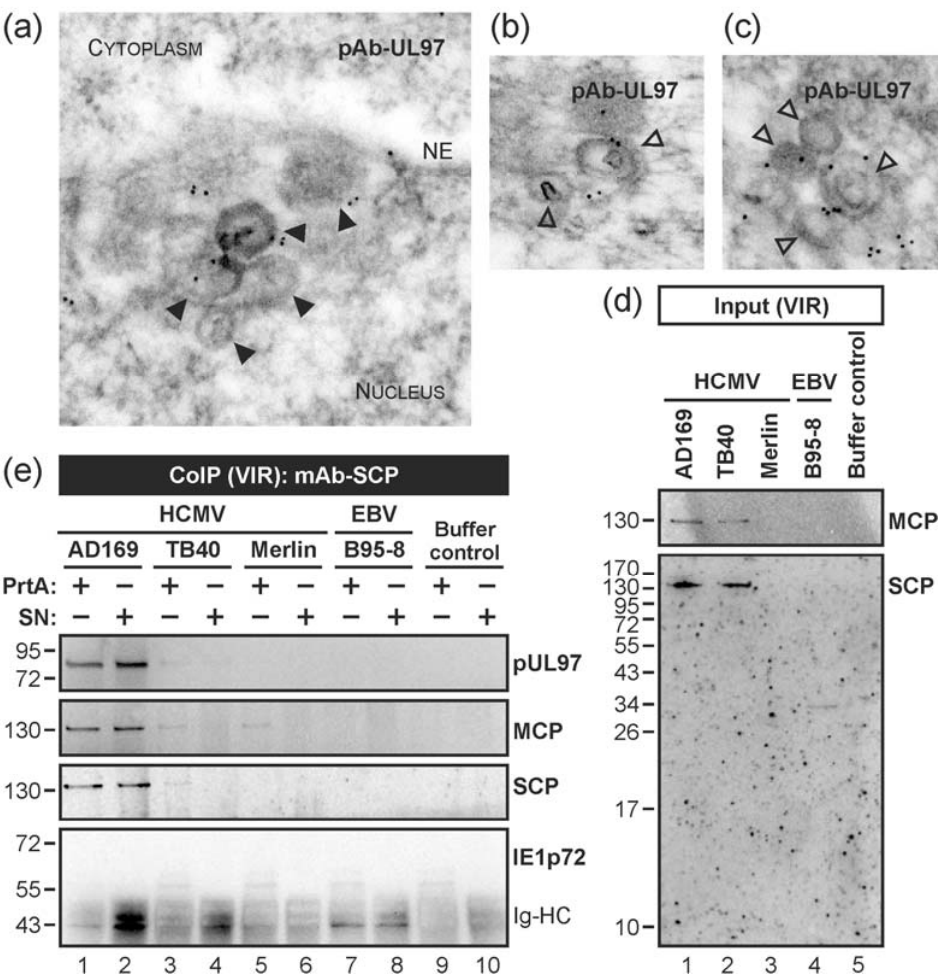
Figure 3. Association of the HCMV-encoded protein kinase pUL97 with viral capsids in the nucleus. ( a – c ) HCMV-infected HFFs were harvested at 3 dpi and subjected to immunogold staining of viral pUL97. Samples were analysed by TEM, 35,970-fold magnification. NE, nuclear envelope; open arrowheads, intranuclear HCMV capsids; filled arrowheads, HCMV capsids budding at nuclear membranes; ( d,e ) CoIP analysis with cell-free virions (VIR) as input. Virions from HCMV strains AD169, TB40 or Merlin (harvested from identical quantities of HFF producer cell layers, i.e. one T175 flask each) were lysed followed by CoIP using protein A-purified mAb-SCP (PrtA) or unpurified supernatant of mAb-SCP hybridoma cultures (SN). EBV strain B95-8 or buffer served as CoIP negative controls (( d ) lanes 4–5; ( e ) lanes 7–10). CoIP samples ( e ) and expression control samples (input; ( d